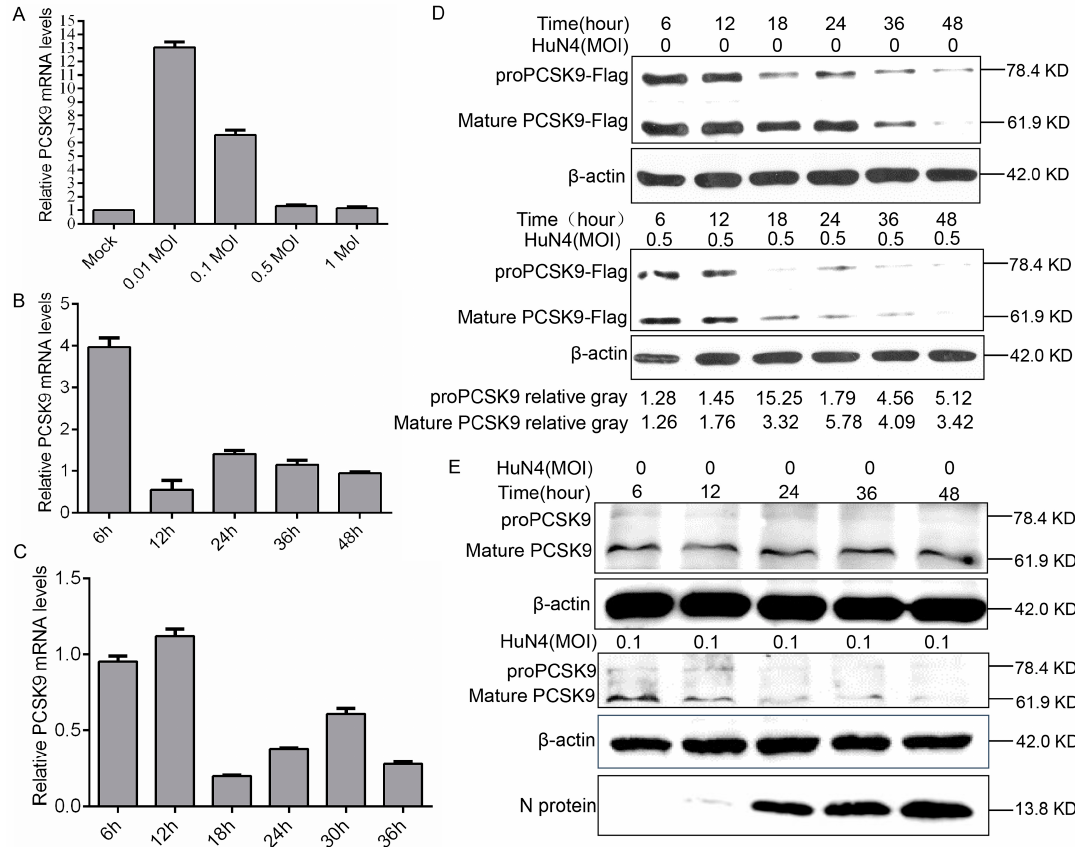
Figure 5. PRRSV down-regulates PCSK9 expression. ( A ) MARC-145 cells were infected with different doses of the PRRSV strain HuN4 (0.01, 0.1, 0.5, and 1 MOI). At 36 hpi, total RNAs were isolated and RT-qPCR was performed to evaluate the relative expression of PCSK9. Error bar: mean ± SEM. ( B ) MARC-145 cells were infected with the PRRSV strain HuN4 (MOI = 0.1). Total RNAs were isolated at the time points as indicated, and the relative expression levels of PCSK9 were determined by RT-qPCR. ( C ) Porcine alveolar macrophages (PAMs) were infected with the PRRSV strain HuN4 (MOI = 0.5). Total RNAs were purified at the time points as indicated, and PCSK9 expression levels were determined by RT-qPCR. ( D ) MARC-145 cells were transfected with the pCAGGS-PCSK9-Flag vector. The cells were infected with the HuN4 virus (MOI = 0.5) or DMEM as control at 36 hpt. Cell lysates were collected and analyzed by WB to assess PCSK9 expression. The values below were calculated from pre-PCSK9 or mature PCSK9 gray values against the corresponding β -actin gray values, then the values from the HuN4-infected cells were normalized to the corresponding values from the HuN4-uninfected cells. ( E ) PAMs were infected with the HuN4 virus at a MOI of 0.1 or DMEM as a control. Cell lysates were collected and analyzed by WB to assess endogenous PCSK9 expression and PRRSV N protein expression.